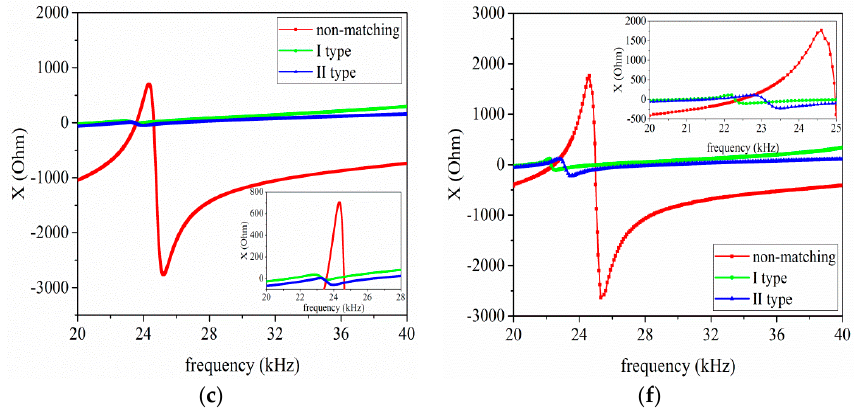
f , f , k and ms f , f , s p effc mp